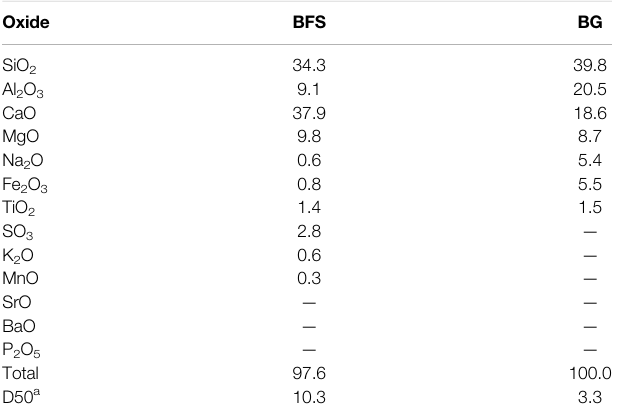
TABLE1| Chemicalcomposition(wt%asmeasuredbyXRF),andtheparticlesize distribution of the materials used in this study. Oxide